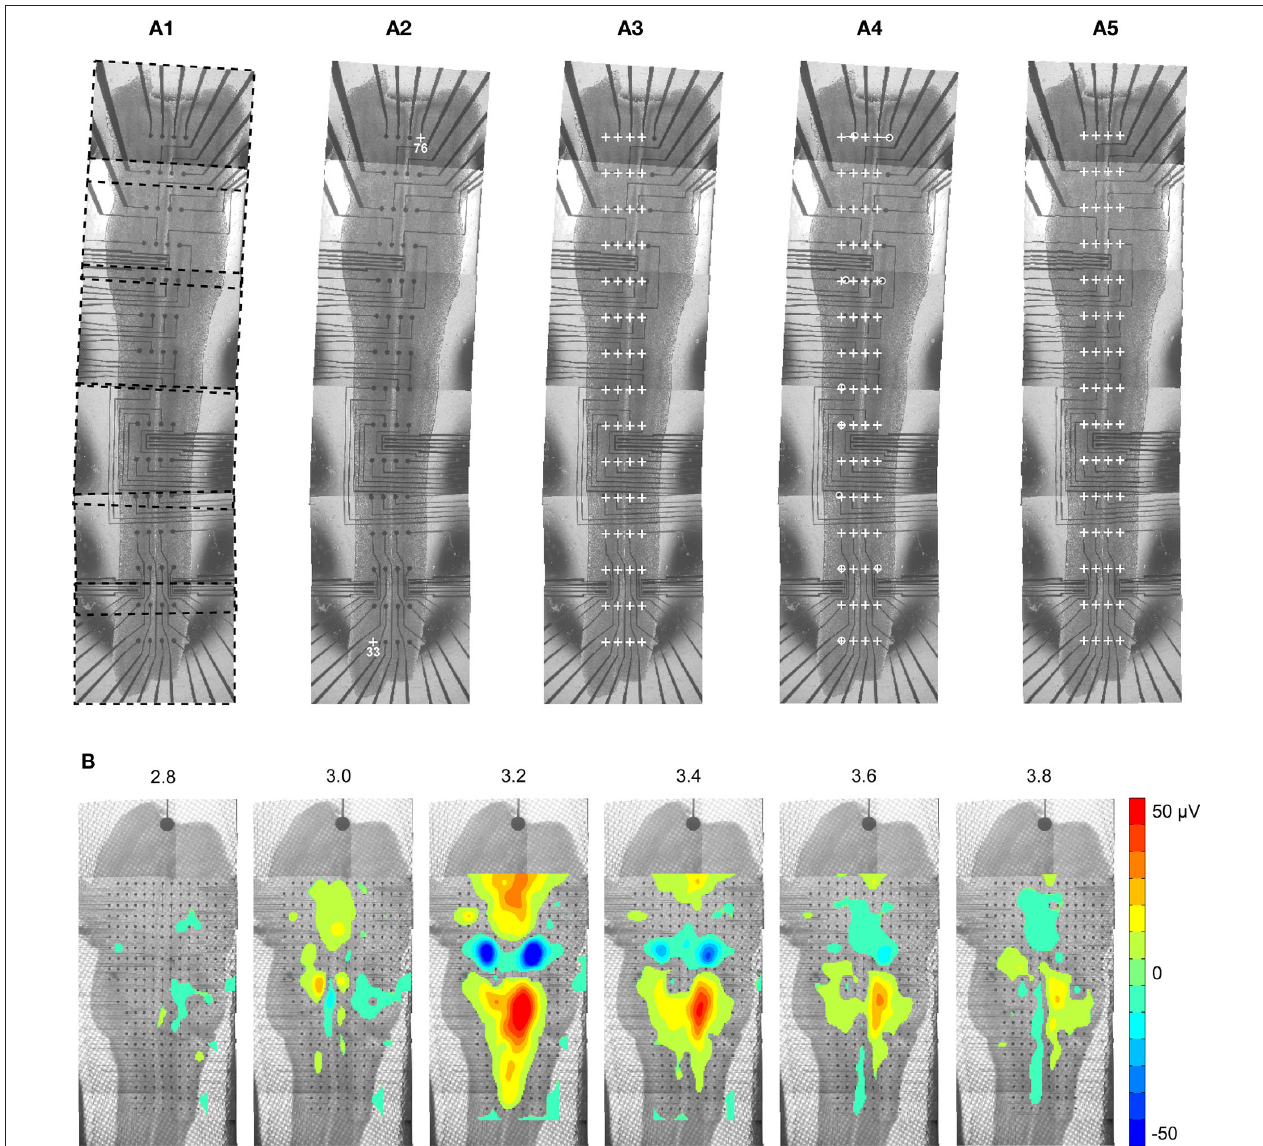
these do not match the electrodes of the picture. (A4) In order to perform appropriate deformation of the picture, the user specifies the correspondence between theoretical and pictured positions for a few electrodes (white circles). These landmarks determine reference pixel displacements that are extrapolated for the whole image. (A5) Result after application of the deformation algorithm. (B) Mapping of activity on a matched anatomical picture of an embryonic hindbrain (data is identical to that of Figure 3B ). In order to improve visibility of the anatomy, values in the noise range (±4 μV) were not